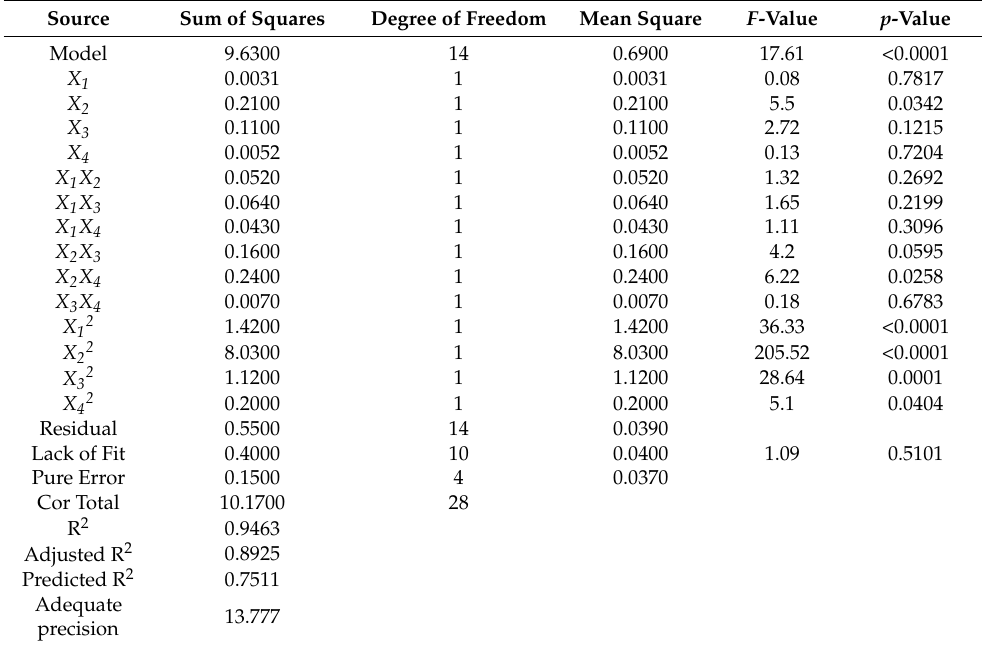
Table 5. ANOVA for response surface quadratic model analysis of